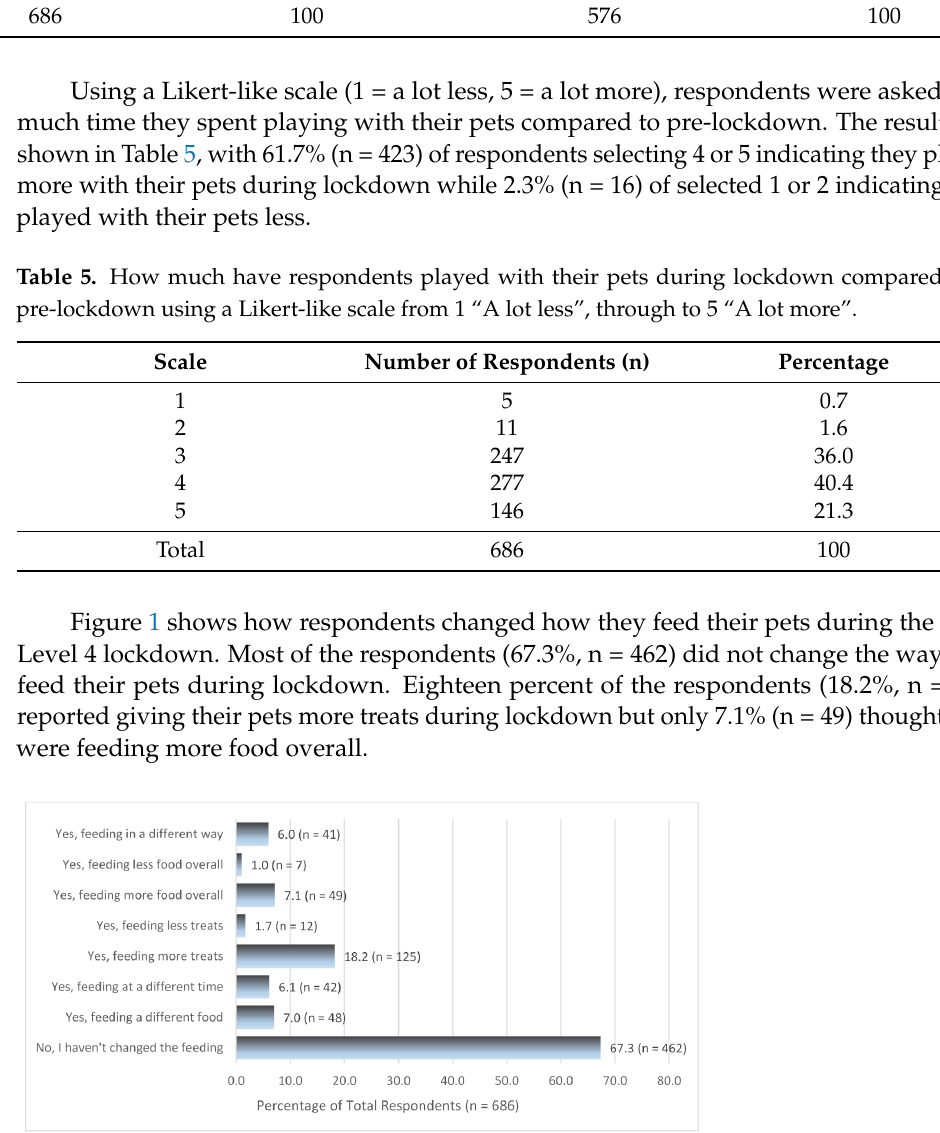
Figure 1. Feeding routine changes during